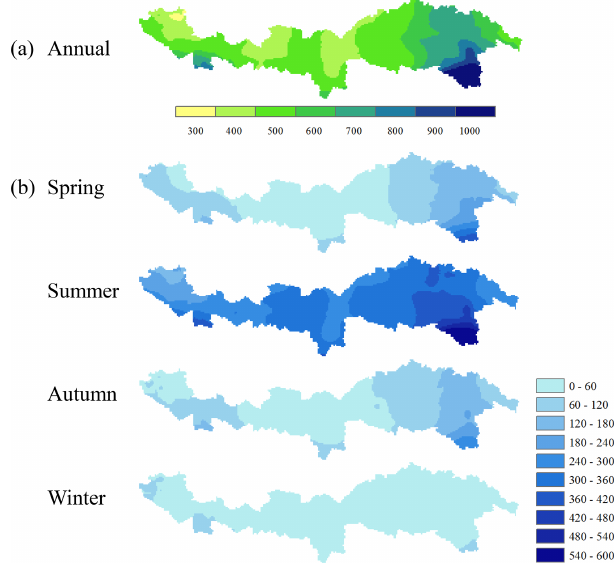
Figure 3. The spatial distribution of P _int (mm) averaged from 1981 to 2016 ( a annual; b